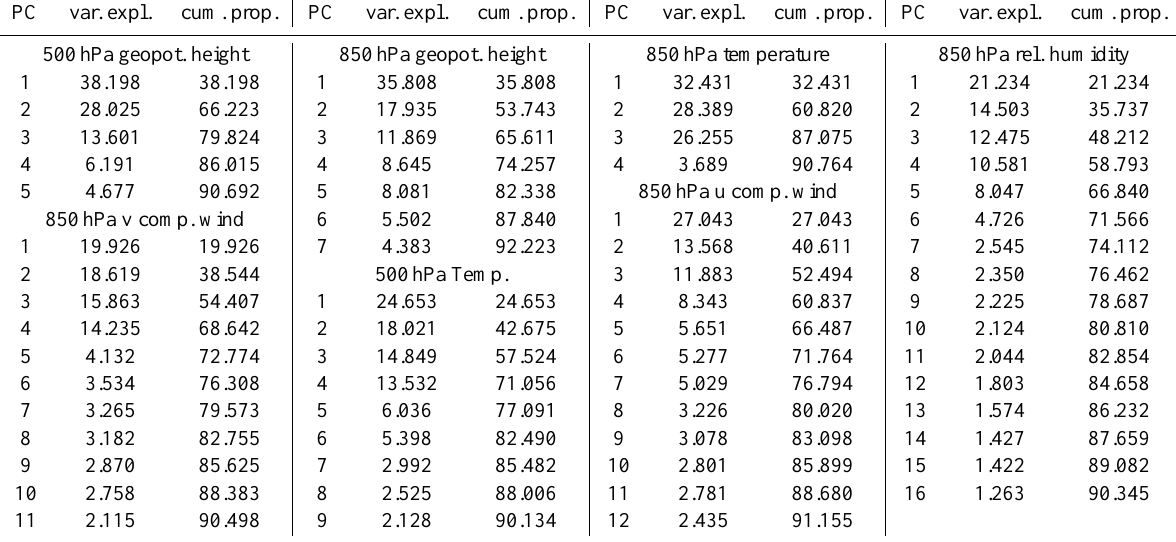
Table 4. Principal components of geopotential height and temperature at 500hPa and 850hPa and relative humidity, u and v components of wind at 850hPa. PC: Principal Component; var. expl.: proportion of variance explained; cum. prop.: cumulative proportion. PC var. expl. cum. prop. var. expl. cum. prop. var. expl. cum. prop. var. expl. cum. prop.